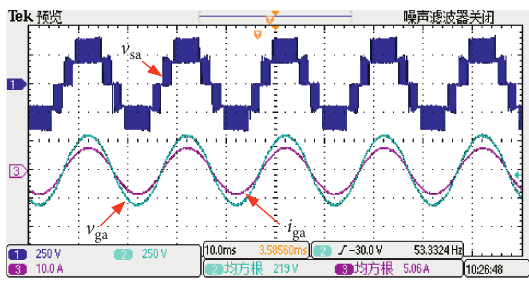
Figure 17: CHB steady-state operating waveforms.